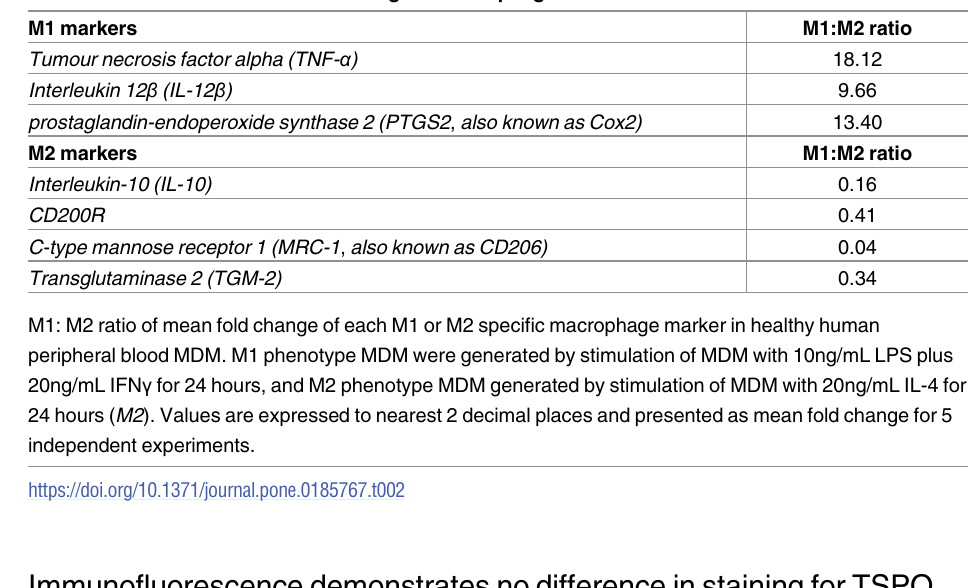
Table 2. M1:M2 ratio of mean fold change of macrophage mRNA markers. M1 markers